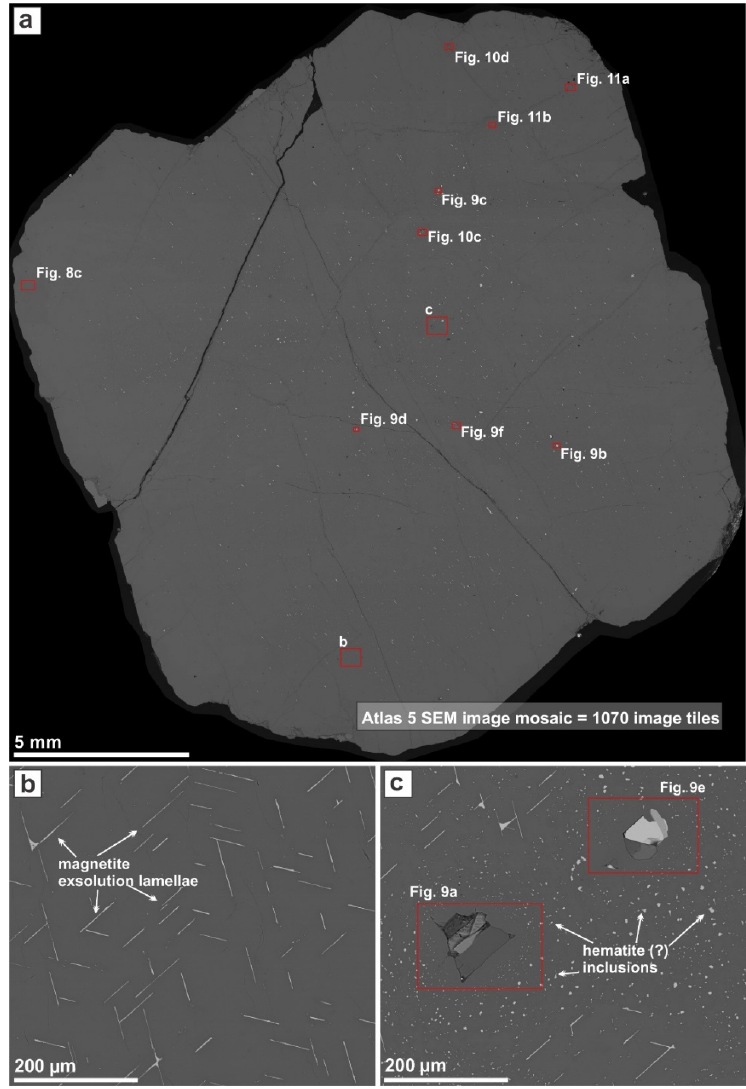
Figure 7. Atlas 5 large-area SEM image mosaic (BSE signal) of one half of the large single crystal of spinel (Parker Mine 10a). ( a ) Atlas 5 large-area SEM image mosaic of the entire half of the spinel crystal. ( b , c ) High-resolution SEM (BSE) images of oxidation-induced exsolution lamellae of magnetite and specks of hematite (?) forming “halos” around the micro-inclusions. The outer boundary of the investigated crystals of spinel contains remnants of the calcite matrix from which it grew (Figure 8a,b). Smaller crystals of spinel can also be observed in this calcite (Figure 8a). A large inclusion of calcite can be found in the center of the crystal (Figure 8c and Figure S3).